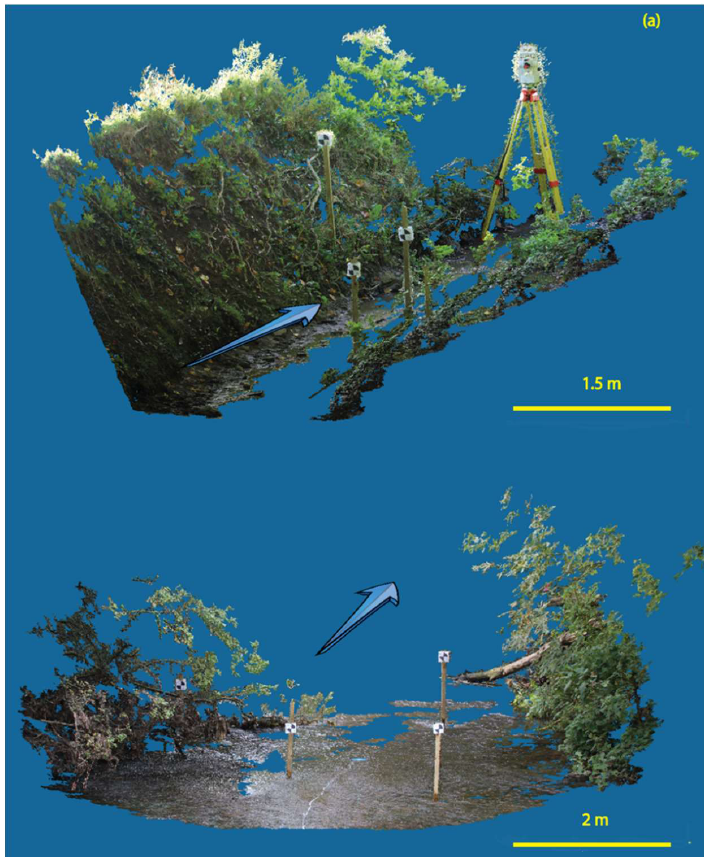
Figure 7. Structure-from-Motion (SfM) derived point clouds obtained for the two 10 m long reaches used for the stereo-camera calibration study: ( a ) Chicheley Brook; and ( b ) River Ouzel. The point clouds were generated with imagery collected for a stereo-camera height setting of 1 m above the water level. The arrow indicates the downstream flow direction. Table 5. Absolute maximum (m) and average precision (m) in path replicability for each of the stereo-camera settings considered with respect to the position of the measurements taken at stereo-camera height 0.5 m. Results refer to each of the 10 m study sites selected for the stereo-camera calibration study. A total of 41 measurements were taken per site and stereo-camera setting.